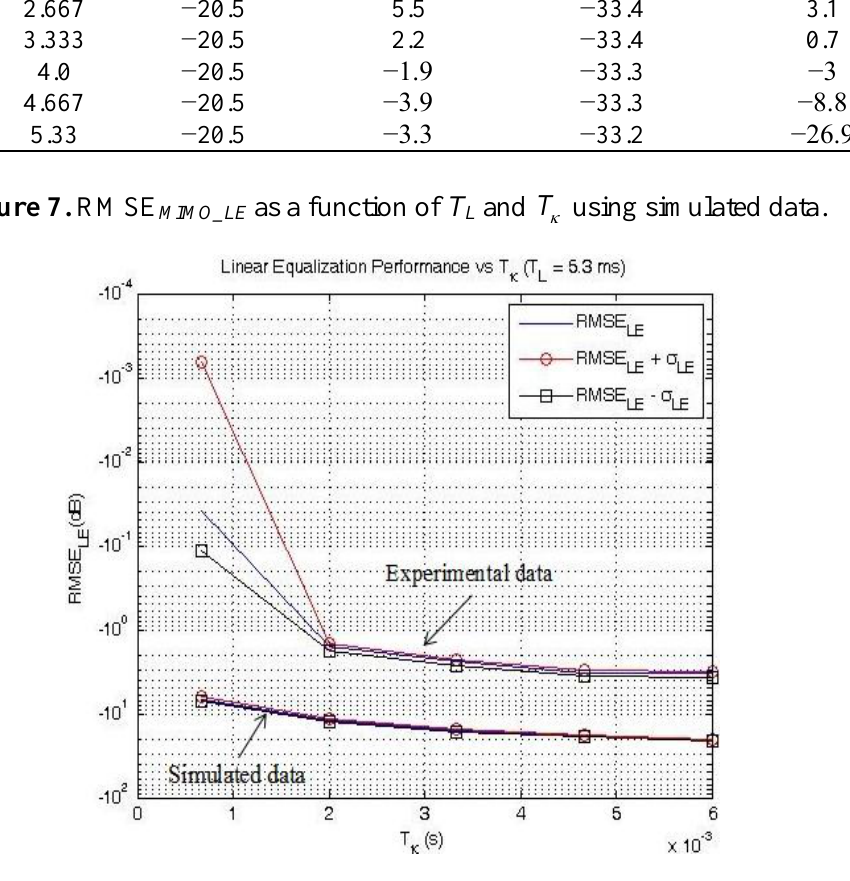
Table 7. RMSE between emitted and received Signals after LE processing, RMSE and after ICLE processing, RMSE